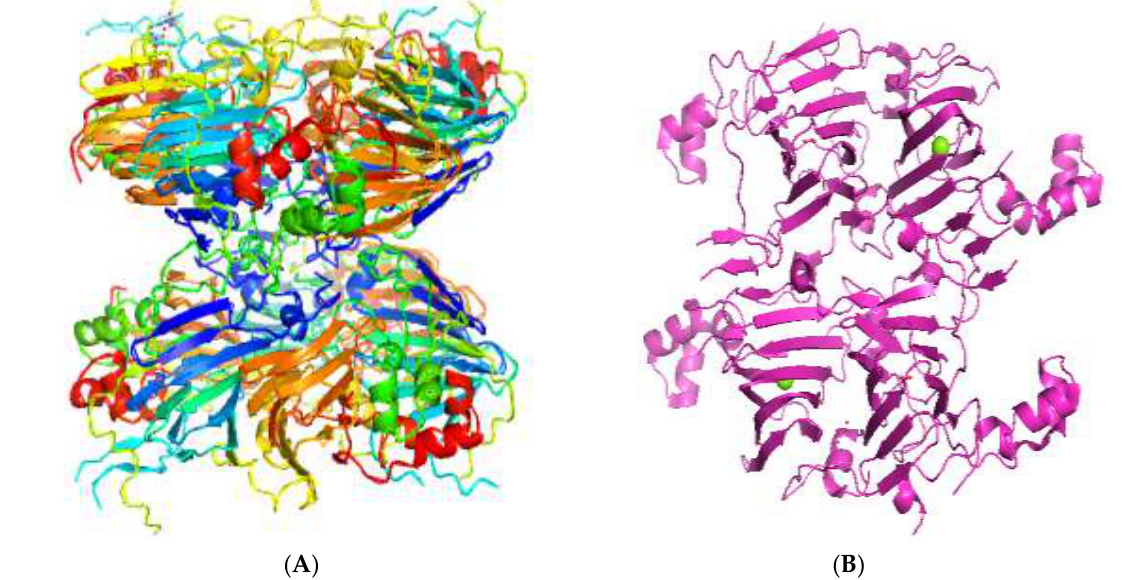
Figure 1. Crystal structure of canola procruciferin, 11S globulin ( A ) and soy glycinin A3B4 subunit ( B ). Table 1. The chemical structure and molecular weight of the compounds evaluated.